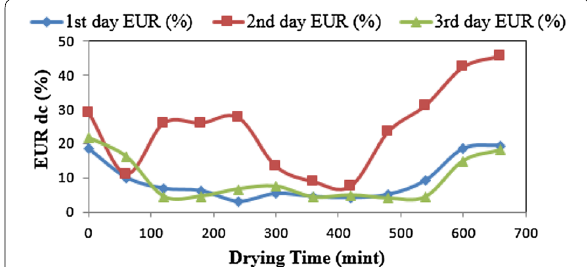
Fig. 2 Variation of energy utilization ratio in drying chamber as a function of drying time of potato